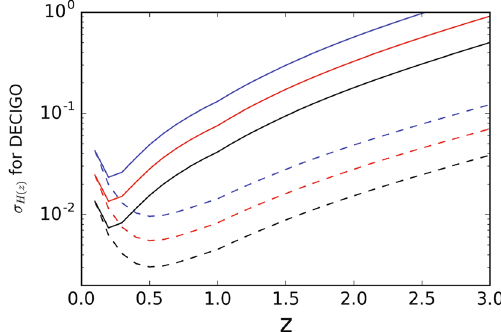
Fig. 5 Relativeerrorof H ( z ) forDECIGO.Thedashlinesandthesolid lines indicate relative errors without and with lens errors respectively. The different colors of of the lines represent different observation time, bluefor1-year,redfor3-year,blackfor10-yearobservationrespectively